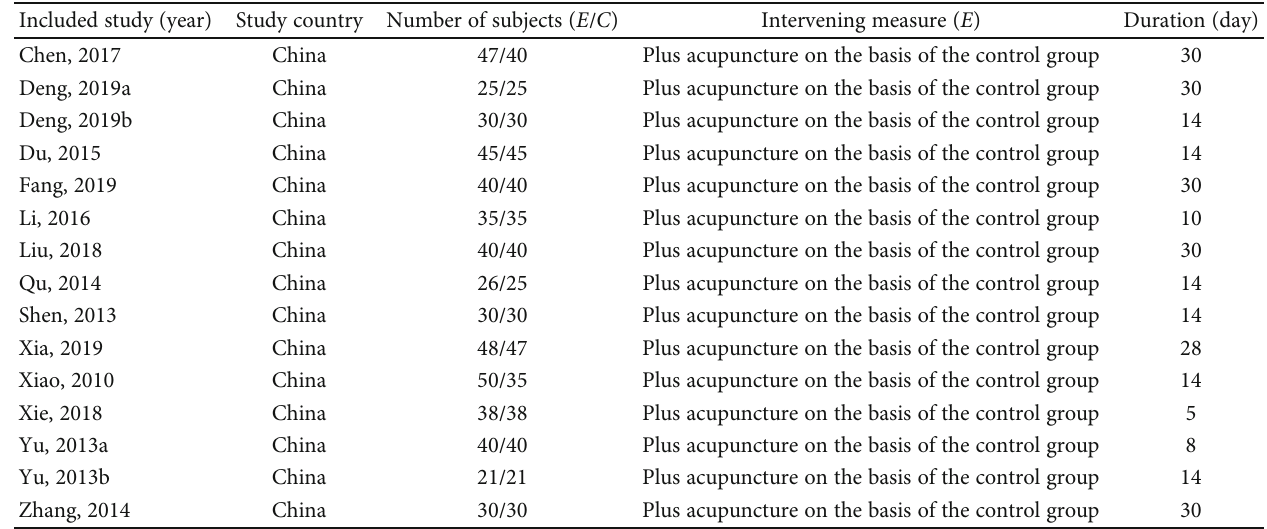
Table 2: Characteristics of included